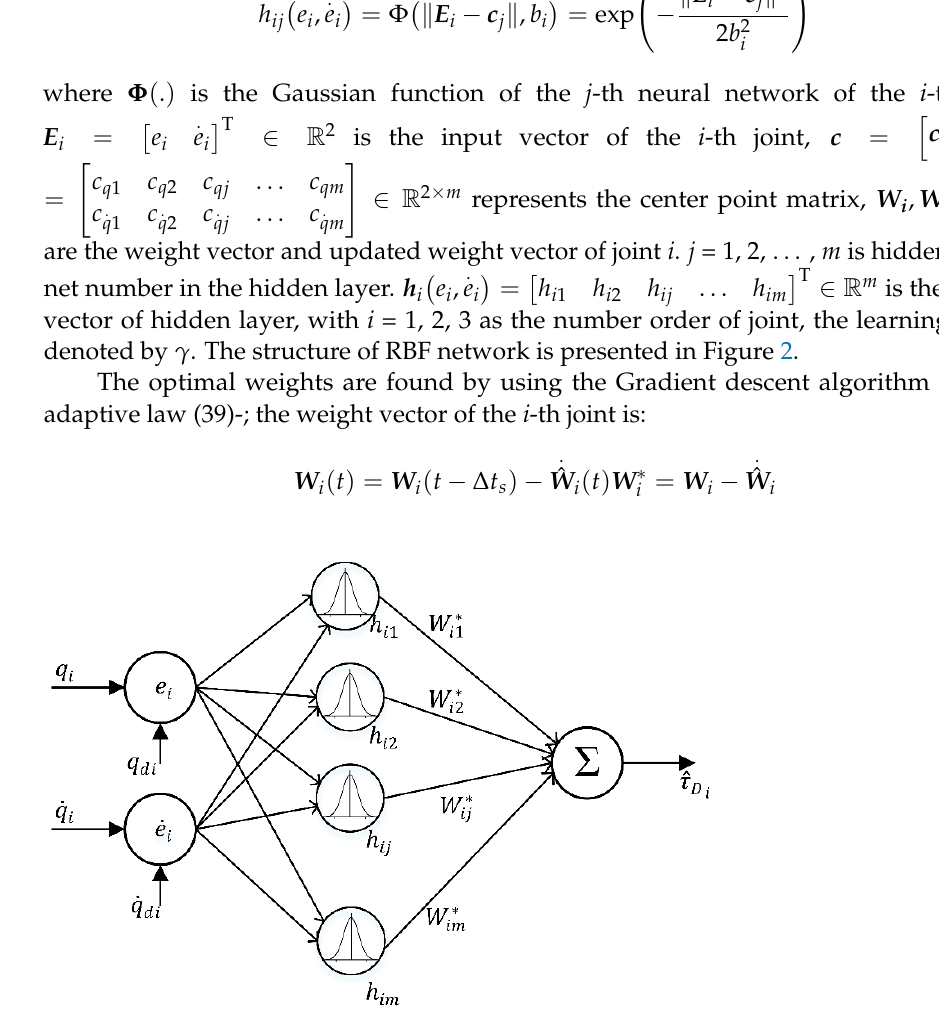
Figure 2. The RFB neural network in this paper.